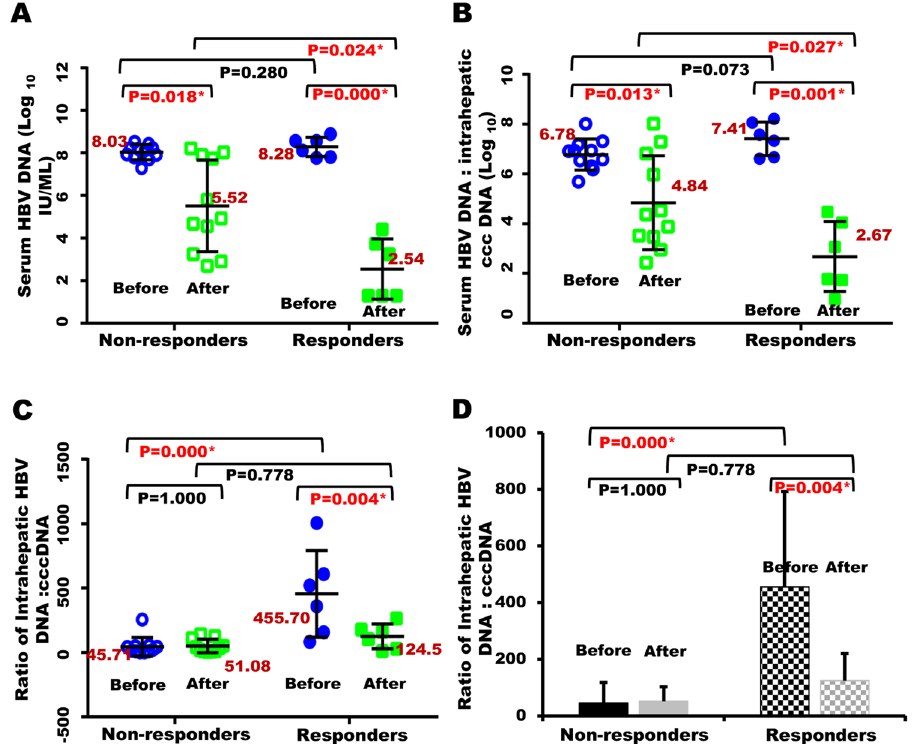
Figure 3. Correlations between levels of intrahepatic (or serum) HBV DNA and cccDNA. ( A ) Relative levels of serum HBV DNA in each individual CHB patient at baseline and after IFN treatment in responders versus non-responders. ( B ) Values of serum [or intrahepatic ( C )] HBV DNA over intrahepatic HBV cccDNA in each individual CHB patient at baseline and after IFN treatment. ( D ) Mean values of intrahepatic HBV DNA over cccDNA in non-responders versus responders at baseline and after IFN